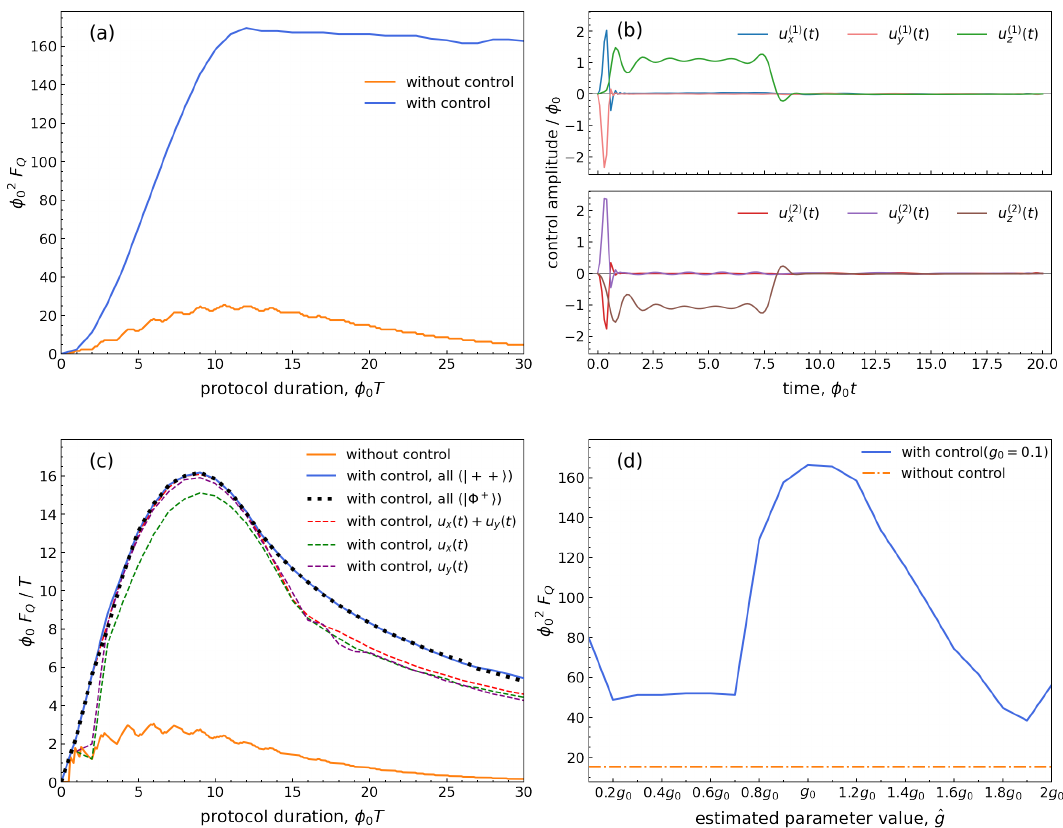
Figure 11: Interaction strength estimation for a two-qubit system with XX coupling, − 2 = 0.1, φ = 1.0, dephasing rate γ = 0.1 (a) The QFI (in units of φ g ) achieved 0 0 − 1 without control and with control optimised over target time T (in units of φ ). 0 (b) Optimal controls obtained using Krotov’s method for the dynamics with T = 20. (c) Normalised QFI (by T ) without control (orange line), with control on both qubits (cid:12) + (cid:11) (black dotted line) as probe, using a product state | ++ 〉 (blue line) or Bell state (cid:12) Φ ( t ) + u ( t ) (red dashed line) on both qubits, restricted with control restricted to u x y ( t ) (green dashed line) or restricted to u ( t ) (purple dashed line). (d) The to u x y QFI achieved at T = 20 by applying controls optimised with different estimated parameter values ˆ g on states evolved under the true parameter value g 0